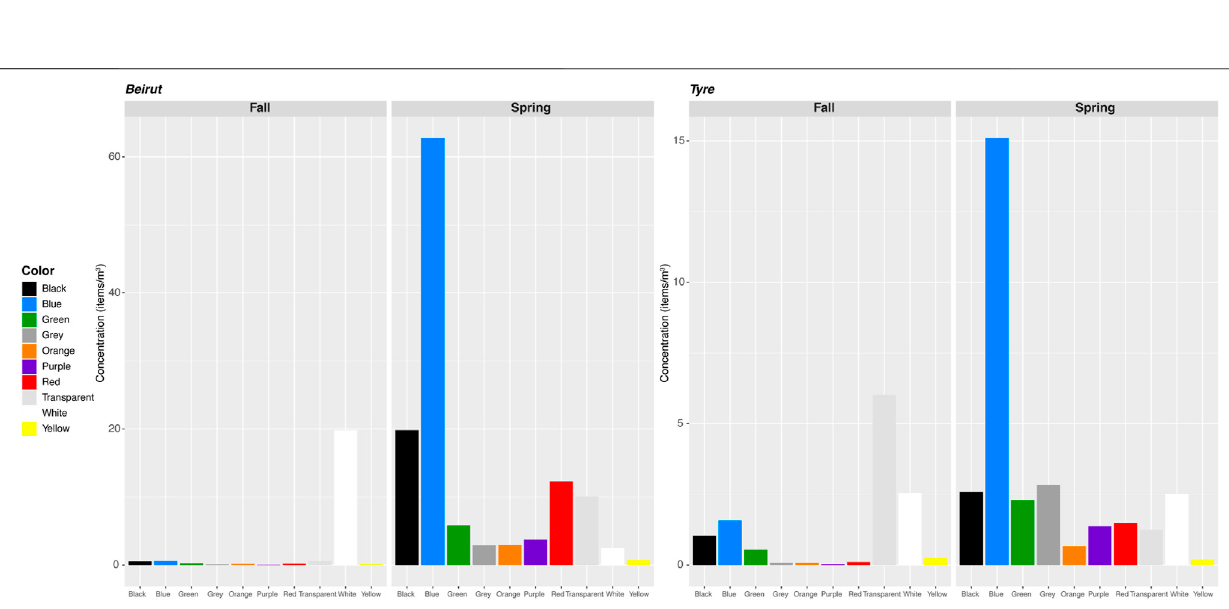
Frontiers in Environmental Science |